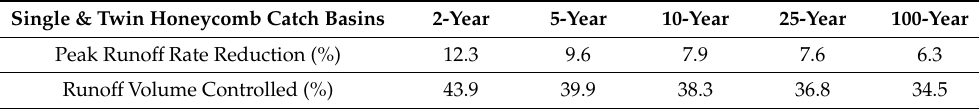
Table 7. Runo ff control performances of single and twin honeycomb catch